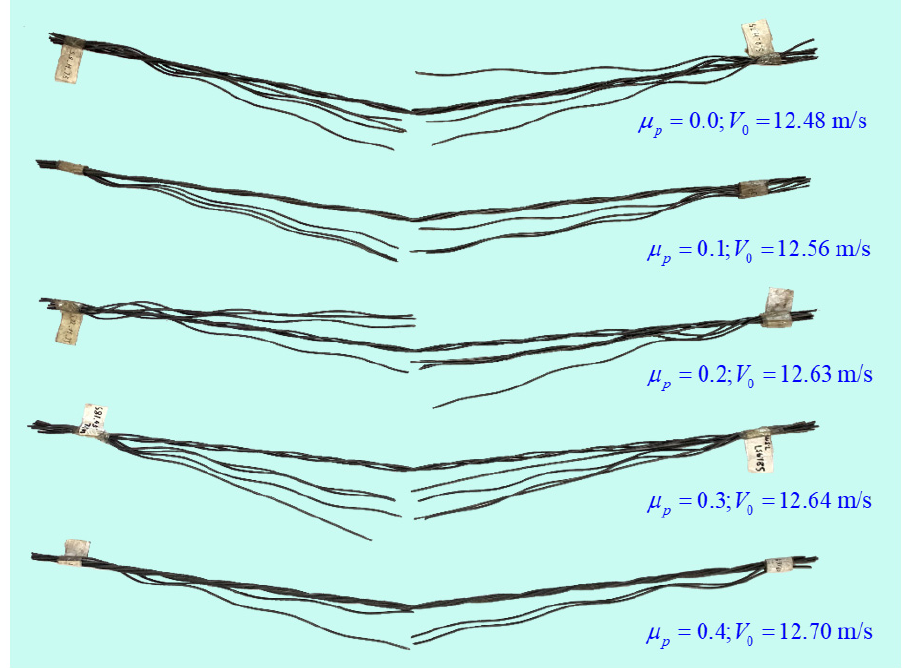
Figure 18. Failure patterns for strand cables with about the same input energy but different pre − stress level.